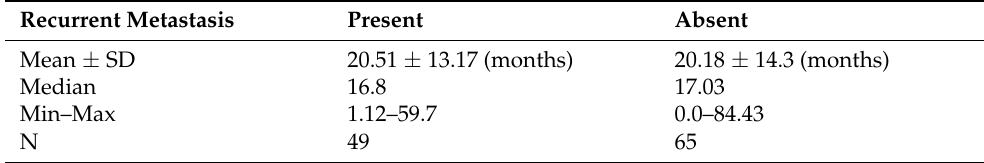
Table 4. Progression group and recurrent